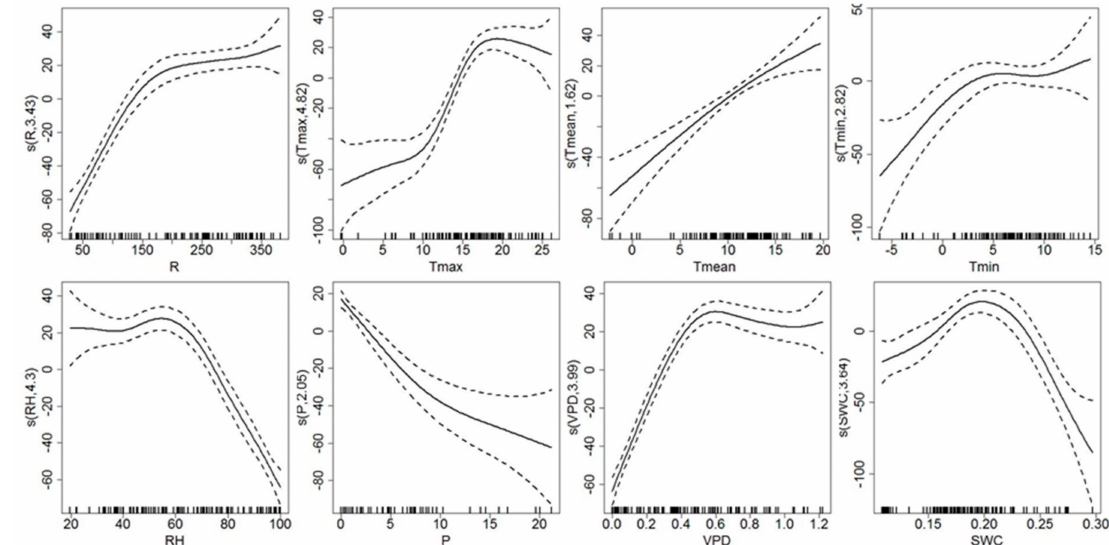
Figure 4. Effects of environmental variables on sap flow density. Each graph is a generalized additive model (GAM) output. Tick marks on the x -axis are observed data points. The y -axis represents the spline function, and the numbers are degree of freedom. Dashed lines indicate 95% confidence intervals.